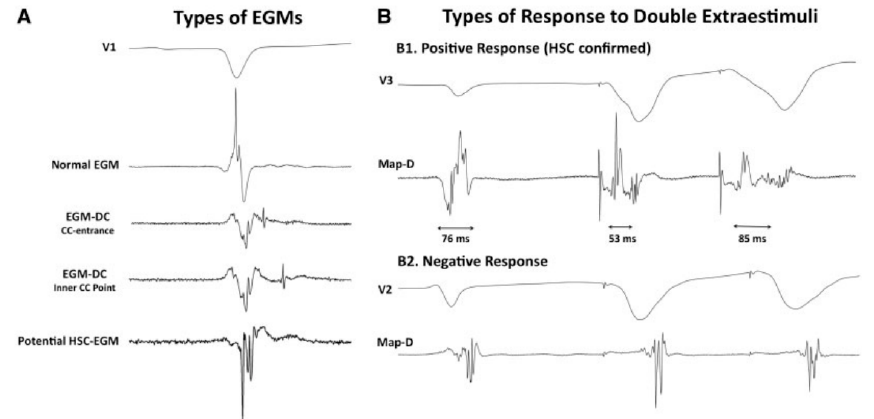
Figure 2 : Electrogram classification and response to a double extraestimulus from Acosta et al. [28]. ( A ) different types of EGMs are shown: from normal through CC-EGMs to potential HSC. ( B ) the response of the potential HSC-EGM after a double extraestimulus is represented, considering a positive response if the local potential is delayed. Ablation was undertaken in those regions feeding the preserved voltage channels with the “scar dechanneling” technique.